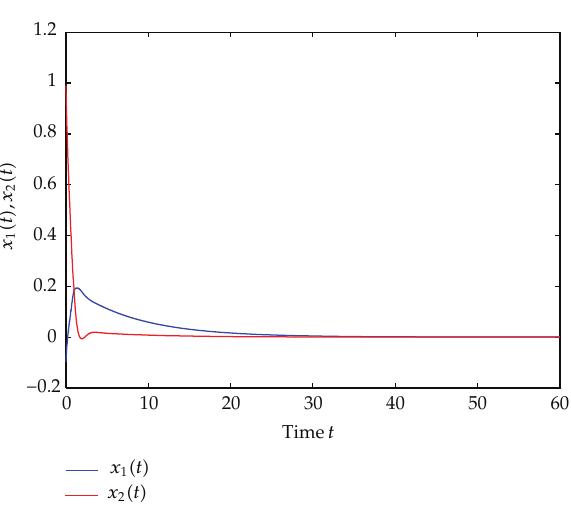
Figure 1: The trajectories of x 1 (cid:6) t (cid:7) and x 2 (cid:6) t (cid:7) of the the nominal Lur’e system with time-varying delays (cid:6) 4.1 (cid:7) .